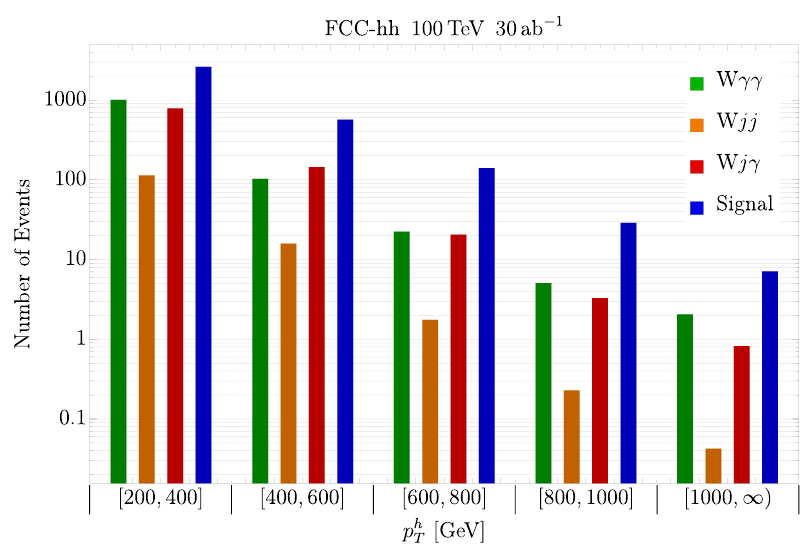
Figure 4 . Number of SM events per p h the FCC-hh assuming 30 ab